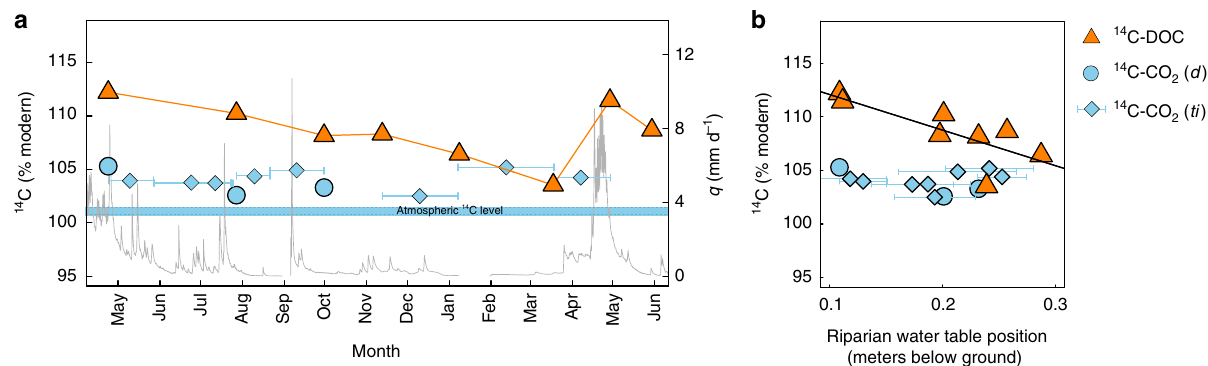
Fig. 1 Hydrograph overlayed with stream water 14 C-CO 2 and 14 C-DOC time series. a Hydrograph showing the stream speci fi c discharge (q) in mm d − 1 (grey line) and stream water 14 C-CO 2 (blue circles (discrete samples ( d )) and bars with diamonds (time-integrated samples ( ti ))) and 14 C-DOC (orange triangles), all expressed in %modern for the period May 2015 – June 2016. The blue rectangle indicates the range in atmospheric 14 C-CO 2 content in the northern hemisphere during 2015 – 2016, according to Graven et al. 68 b scatterplot showing the stream water 14 C-CO 2 and 14 C-DOC as a function of riparian water table position (in metres below ground surface). The solid line represents the least square linear regression model, 14 C-DOC = WT R × − 33.3 + 115.4, R 2 = 0.53, p = 0.02). The original 14 C data are listed in the Supplementary